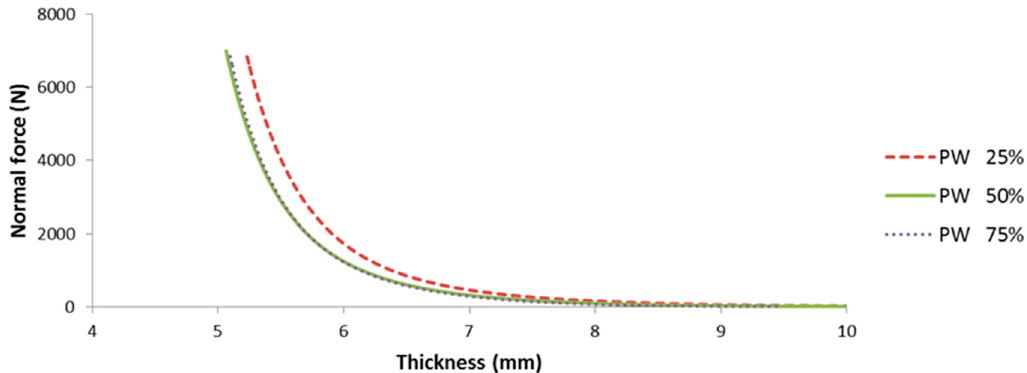
Figure 7. Change in normal forces of the multi-layered fiber preform with respect to the thickness by compressive force with varying ratio of PW to UD from 0% to 100%.